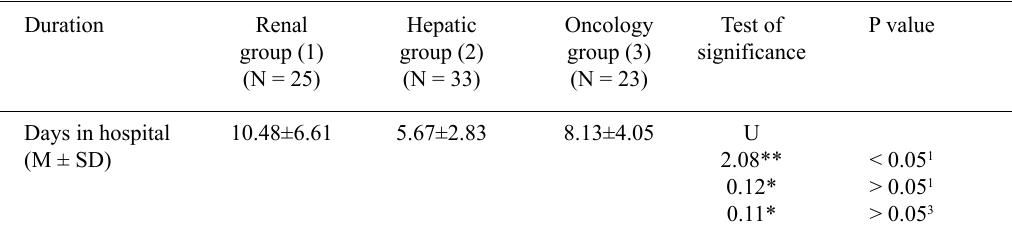
table 1. Different patient’s duration of the stay in hospital for all groups.